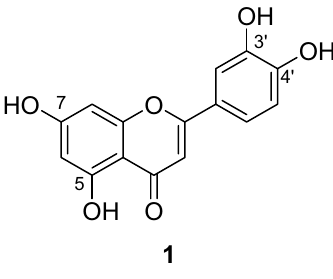
Figure 1. Structure of luteolin, a